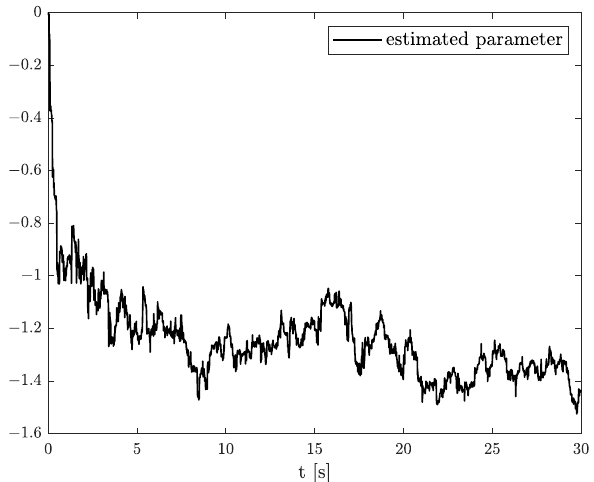
Figure 17. Parameter estimation for y -axis noise.